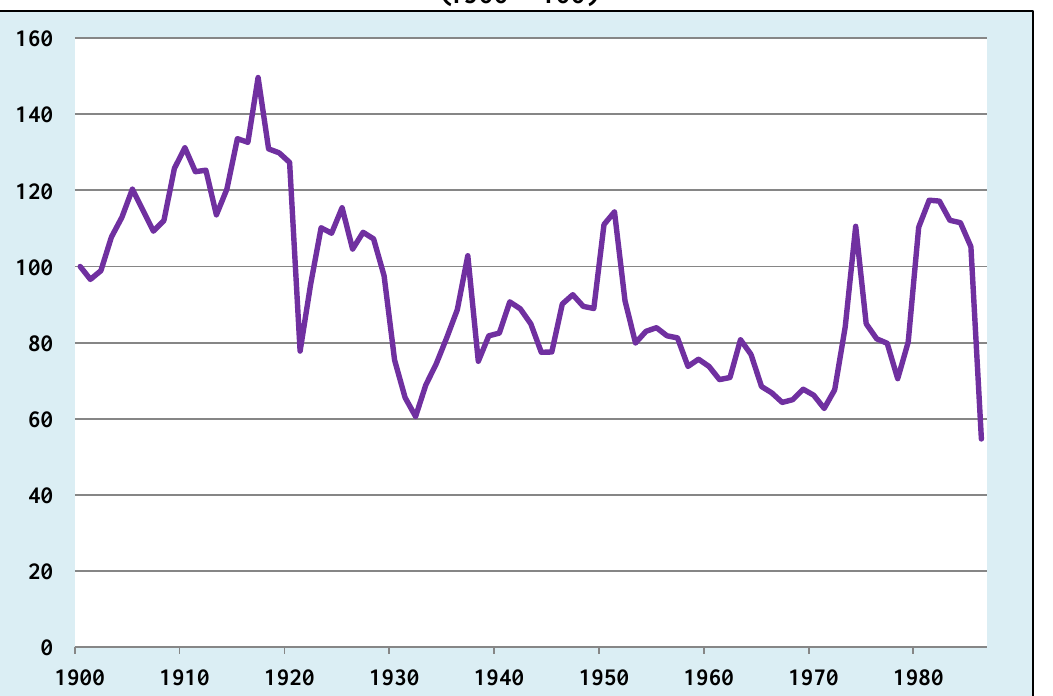
Figure 1: Terms of Trade for Primary Products, 1900-1986 (1900 =